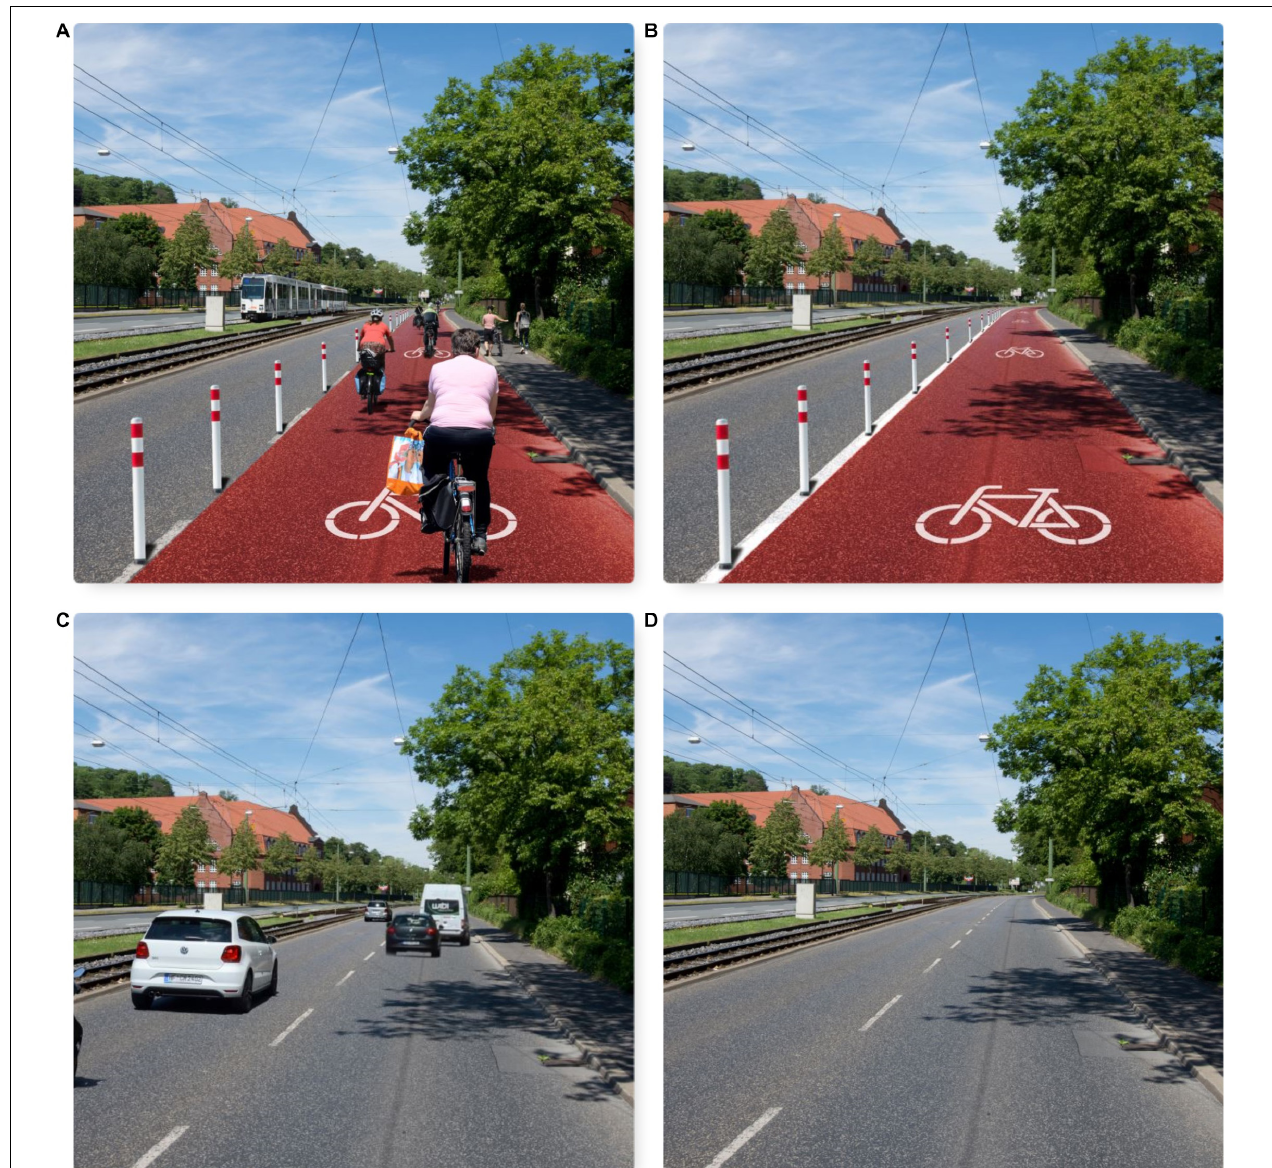
FIGURE 4 | Photomontages used for experimental online study 3. On the left, infrastructure and behavior are pro-eco (A) and pro-car (C) , respectively. On the right, only infrastructure without behavior [pro-eco (B) or pro-car (D) ] is shown. (Photos: Michael